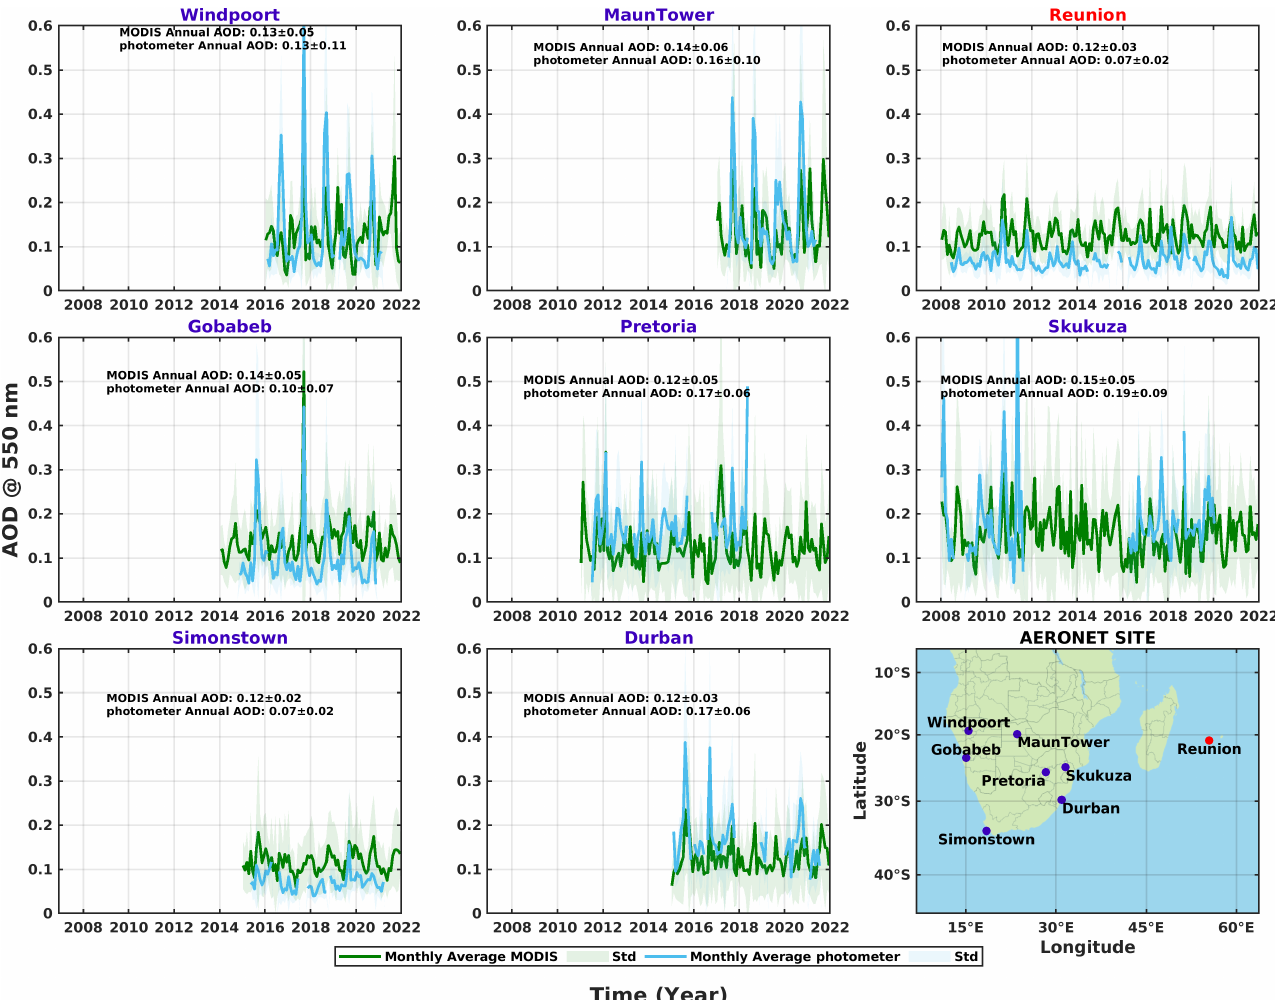
Figure 3. Time series of AOD at 550 nm over the eight sun photometer sites. Solid lines (shaded area) show monthly average (±1 standard deviation) from the sun photometer in blue and from MODIS observations in green. Multiyear annual AOD values for both instruments are provided during the study period. The bottom right panel represents the location of sun photometer